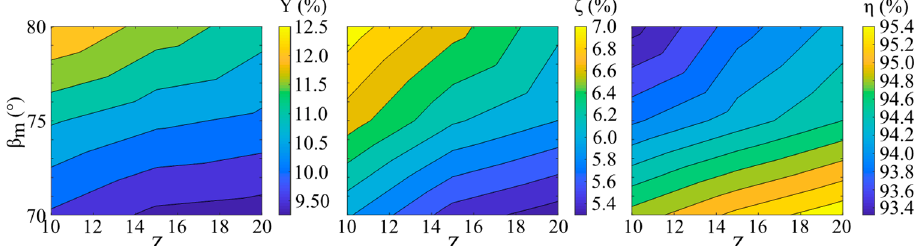
Figure 11. Distribution of stator performance index as a function of vane count and outlet metal angle: total pressure loss Y, kinetic loss coefficient ζ and stator efficiency η .